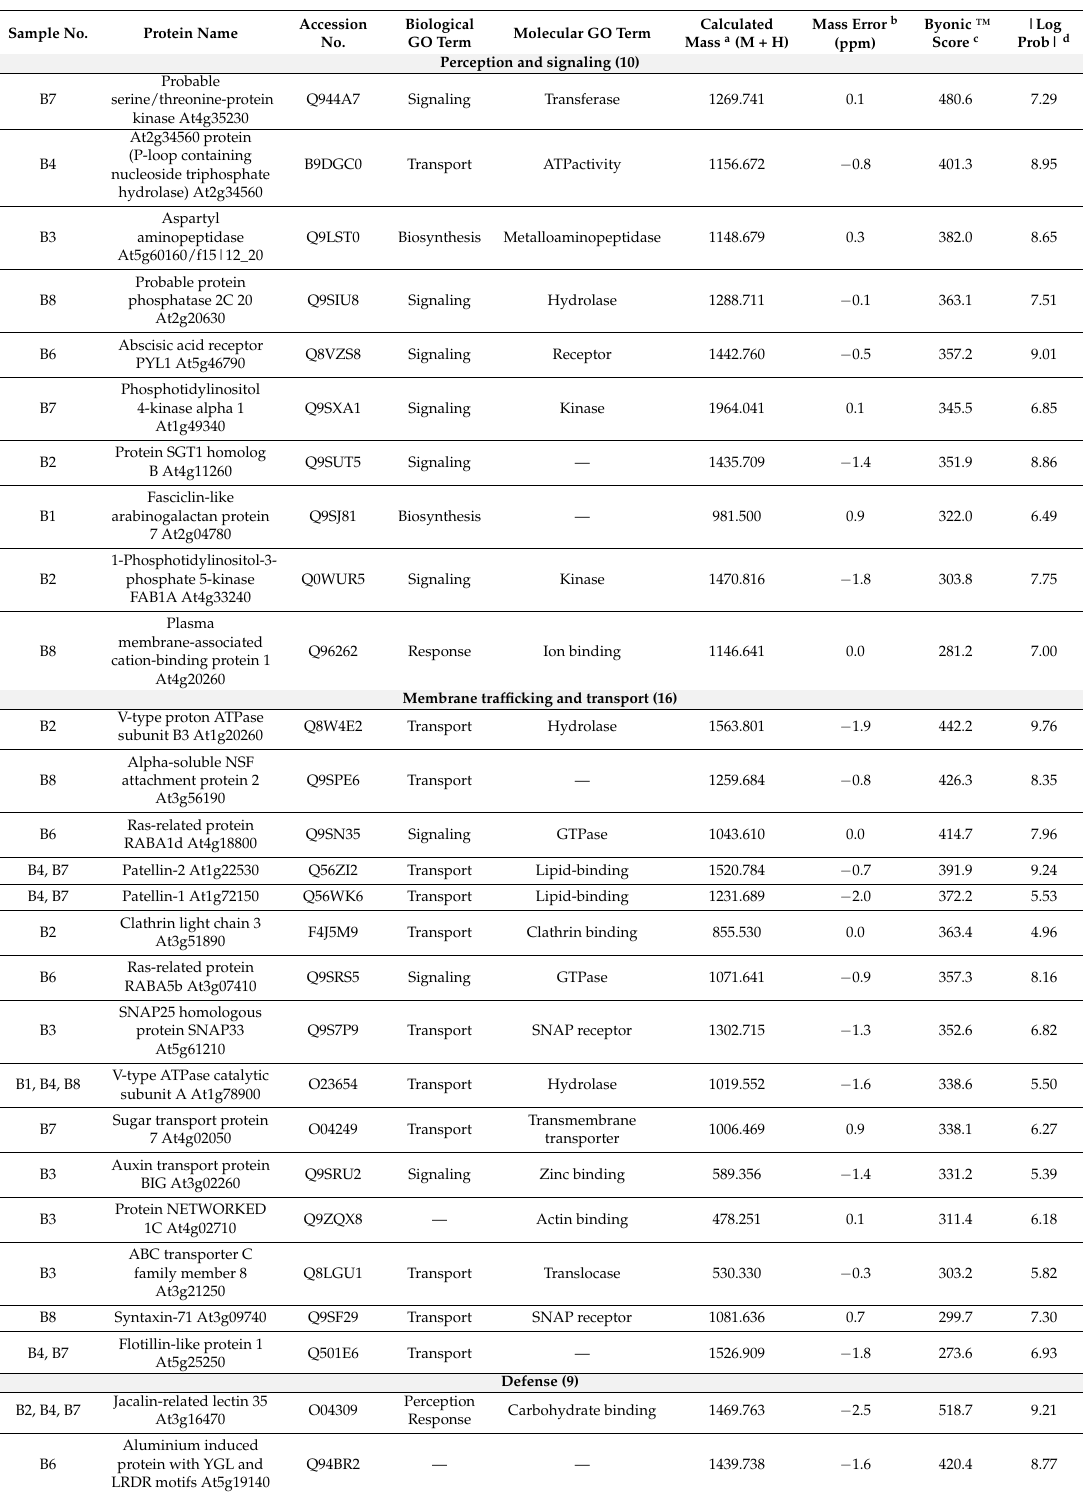
Table 2. LC-MS/MS identification of A. thaliana PM-associated responsive proteins from selected 2D SDS-PAGE spots of control, 0- , 6- , 12-, and 24 h fractions subsequent to ergosterol treatment and arranged according to functional categories (Supplementary Data Sheet 2). Sample